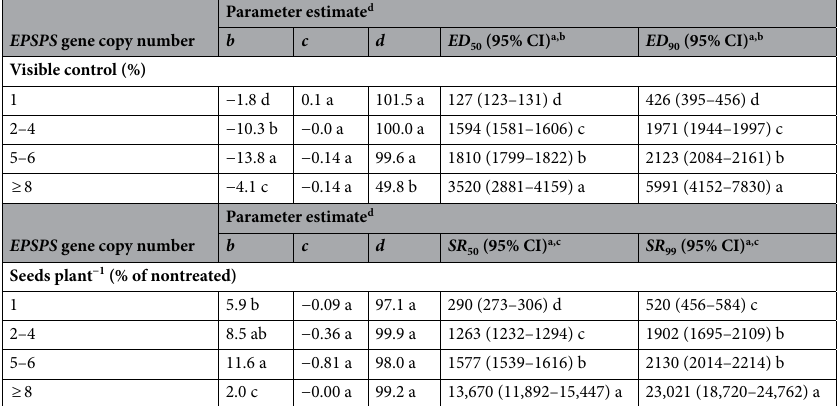
Table 3. Estimated parameters (b = slope, c = lower limit, d = upper limit, e = inflection point [ED50 or SR50]) from a four-parameter log-logistic model used to describe the percent visible control and seed production (no. plant −1 ) of Bassia scoparia with varying EPSPS gene copies (1, 2–4, 5–6, and ≥ 8) in the presence of glyphosate applied at 0, 108, 217, 435, 870, 1265, 1740, 2214, 3084, and 3954 g ae ha −1 in the field averaged over 2 years conducted at the Montana State University Southern Agricultural Research Center near Huntley, MT, USA. a Values in parenthesis represent the 95% confidence interval of the respective parameter estimate. b ED